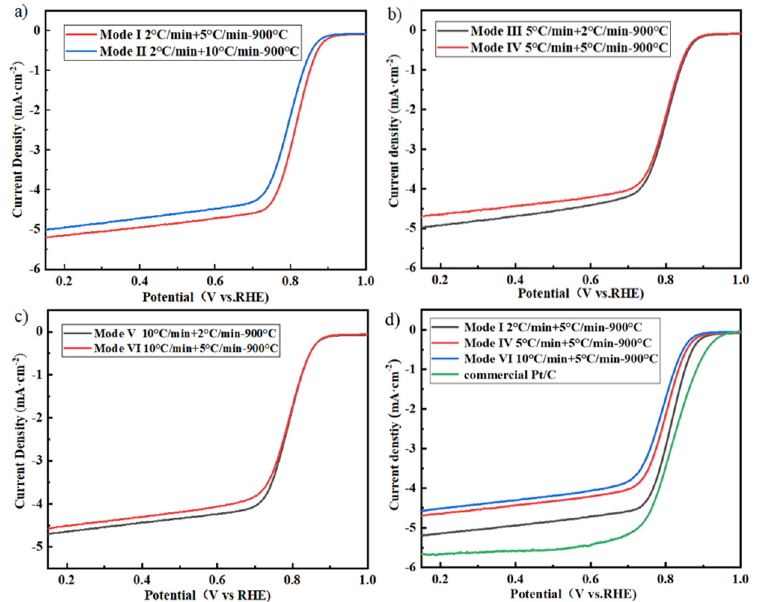
Figure 6. ( a ) LSV curves of Co–ZIF–8 pyrolyzed with a heating rate of 2 °C/min in the first stage; ( b ) LSV curves of Co–ZIF–8 pyrolyzed with a heating rate of 5 °C/min in the first stage; ( c ) LSV curves of Co–ZIF–8 pyrolyzed with a heating rate of 10 °C/min in the first stage; ( d ) LSV curves of